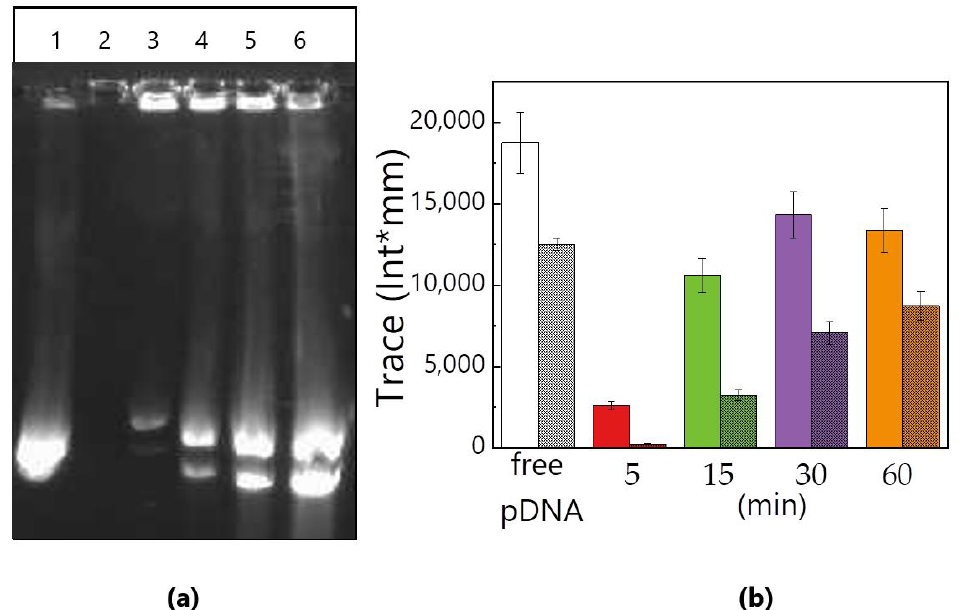
Figure 6. ( a ) Agarose gel electrophoresis of the lipoplex-AuNS system (100 pM AuNSs) irradiated at 400 mW at different times: 5 min (lane 3), 15 min (lane 4), 30 min (lane 5) and 60 min (lane 6). Lane 1: free pDNA as the control; lane 2: non-irradiated lipoplex-AuNS system and ( b ) Quantification of the pDNA release as a function of the time of irradiation (min). Traces (Int*mm) of the fluorescent bands of coiled (unstriped bars) and supercoiled (striped bars) pDNA conformations.